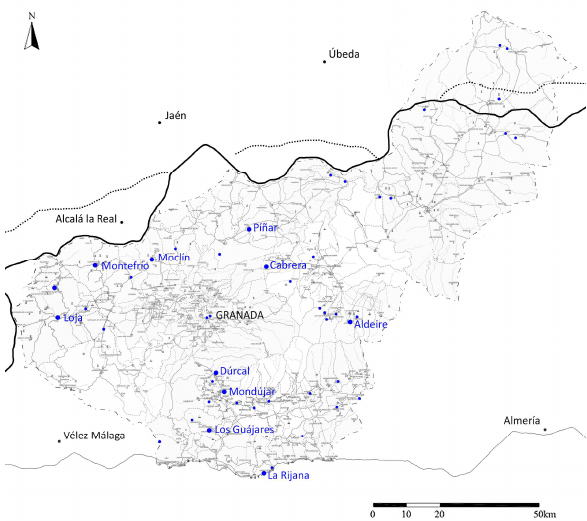
Figure 1. Fortresses documented so far in the province of Granada.